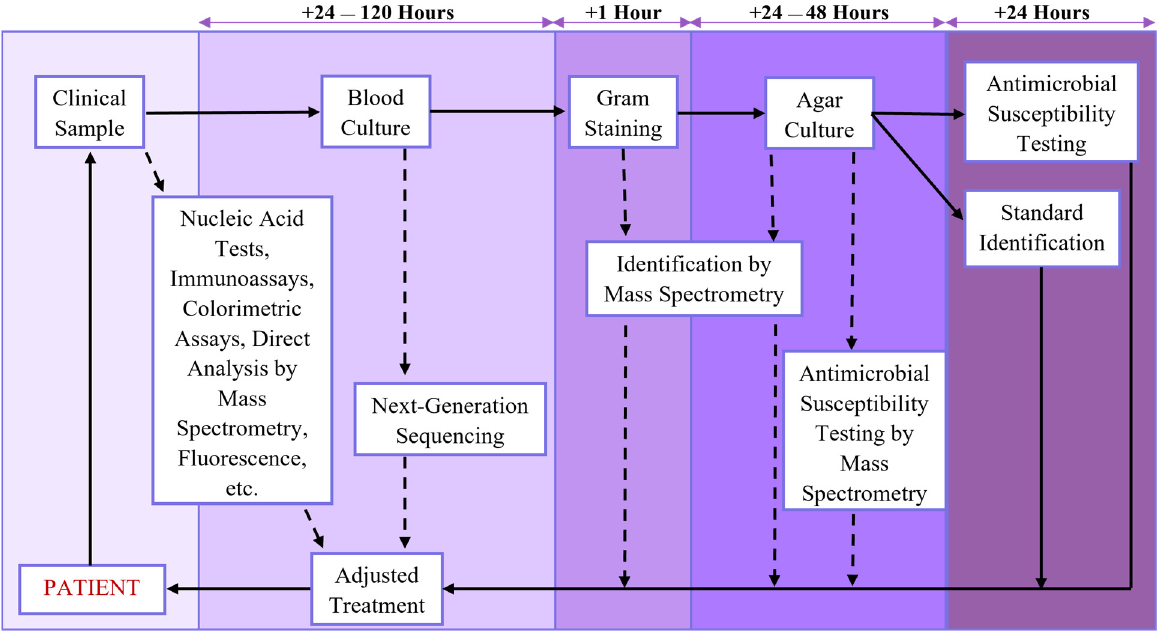
Figure 1. An example diagnostic workflow showing a standard blood culture procedure (solid lines) and various intervention points and techniques for reducing time (dashed lines).